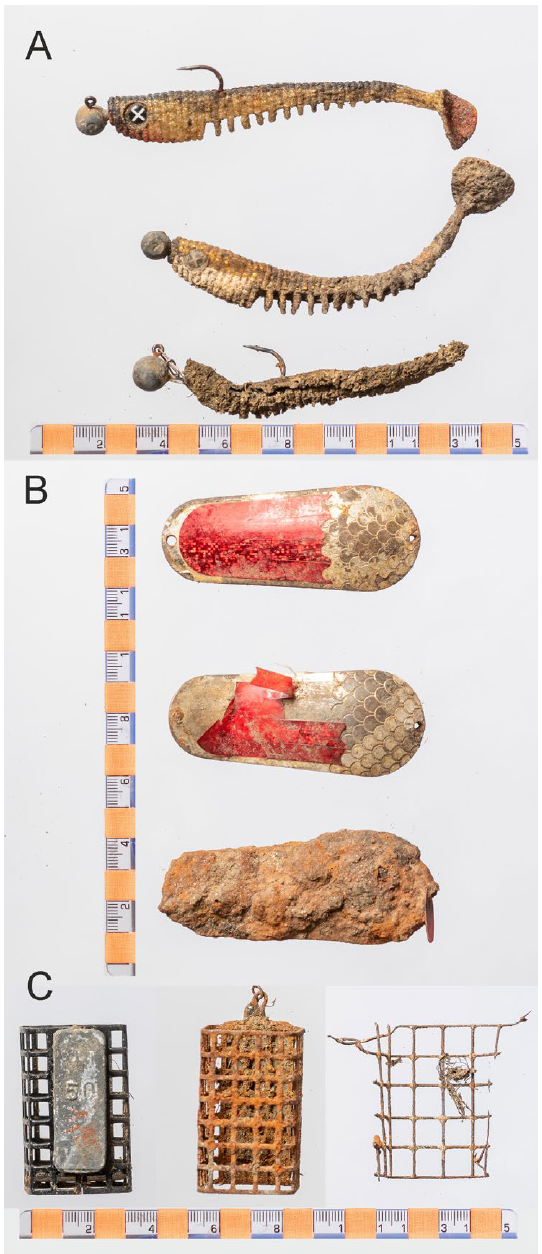
Figure 3. Different stages of degradation of ( A ) soft bait and ( B ) hard bait as well as ( C ) feeder baskets found in Lake Eixendorf.